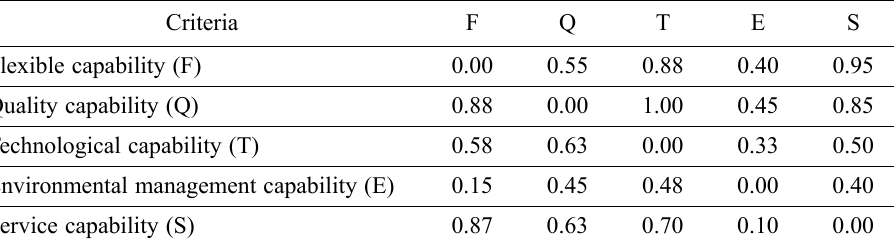
Table 3. Original interrelation